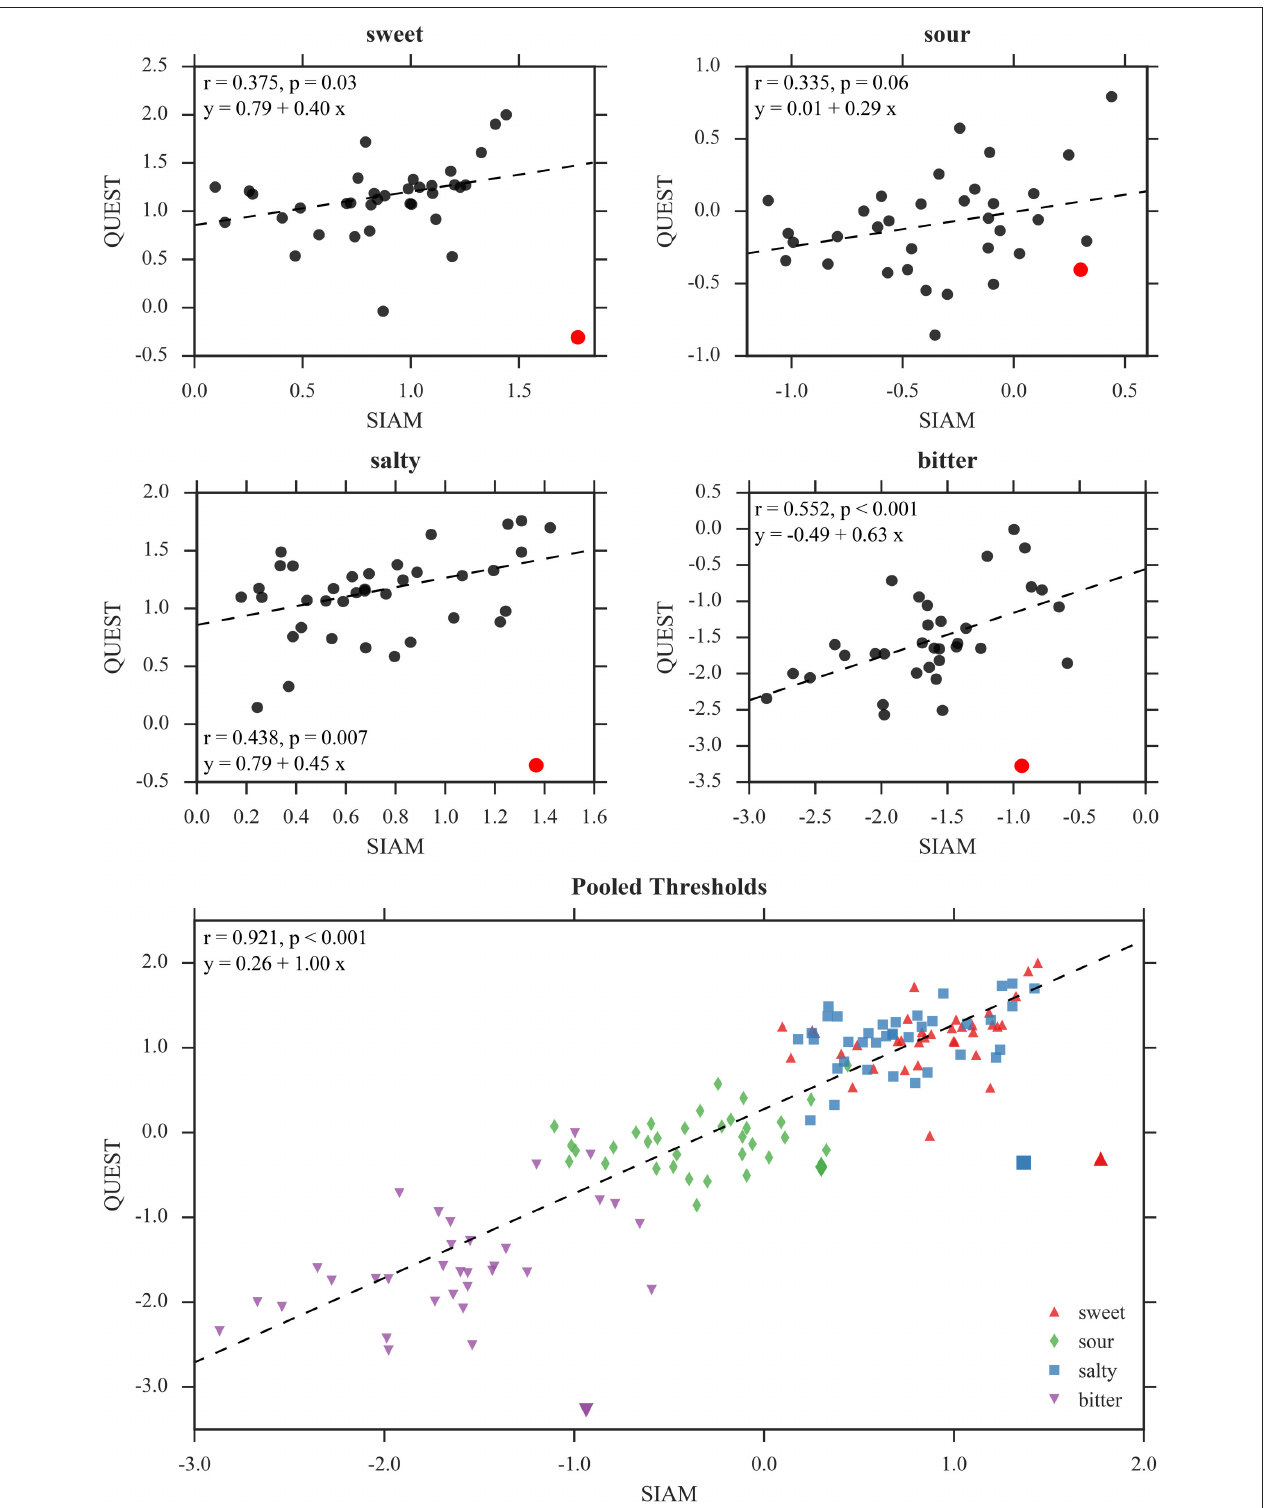
FIGURE 9 | Correlations between mean threshold estimates of SIAM and QUEST. Top panels: Separate correlations calculated for each individual taste quality. The large red dots depicts the “outlier” that was excluded from the analyses presented here (but see text for coefficients with these data included). Bottom panel: Data pooled across all taste qualities. The “outlier” is depicted by larger markers than the other data points and was excluded from correlation analysis. All values in log 10 m M